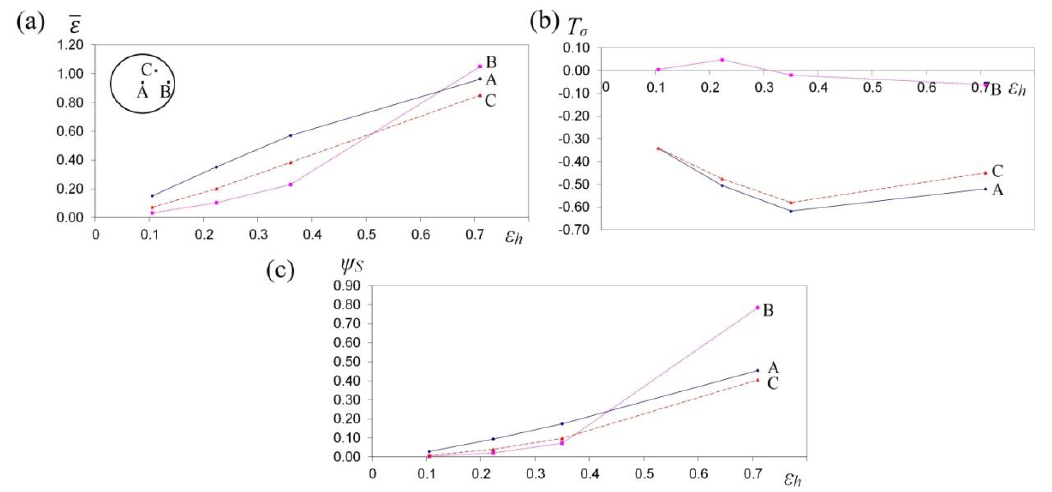
Figure 13. The variation in effective strain ε ( a ), stress triaxiality T σ ( b ) and the deformation damage factor Ψ S ( c ) at selected points A, B and C during the cogging process of the X32CrMoV12-28 die steel specimens in convex anvils with an angle of 130°.